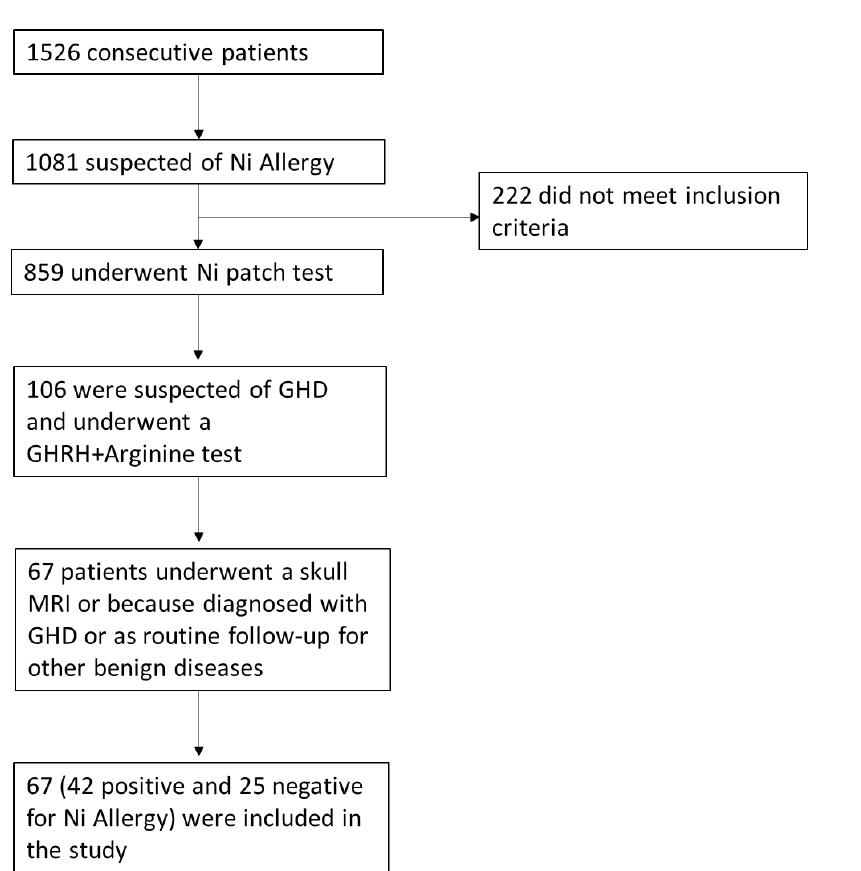
Figure 1. Flowchart of patient enrolment. Abbreviations: Ni, Nickel; GHD, Growth Hormone Deficiency; GHRH, Growth Hormone Releasing Hormone; MRI, Magnetic Resonance Imaging.